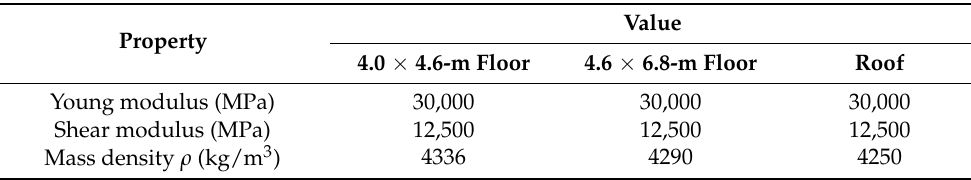
Table 3. Properties of the shell elements (thickness = 68 mm) representing the concrete slabs in configuration B1-RC. Reprinted from Reference